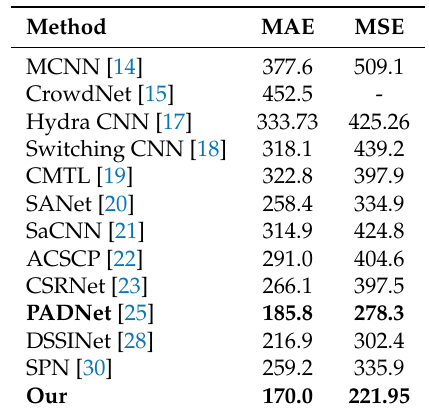
Table 4. UCF_CC_50 performance